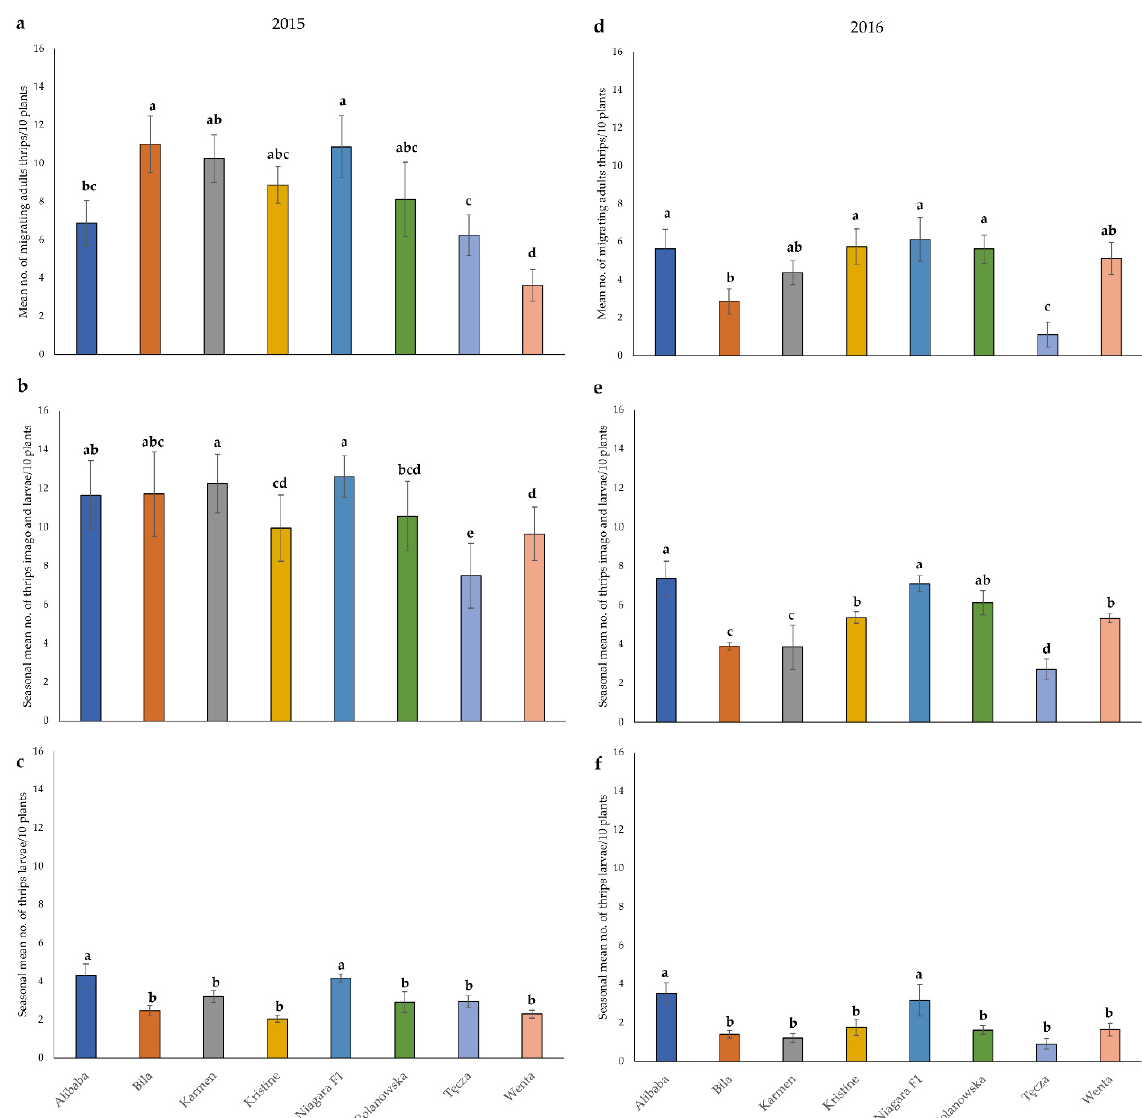
Figure 1. Mean (±SE) Thrips tabaci abundance on onion cultivars: ( a , d ) during onion plants colonization by the adults, ( b , e ) throughout the growing season by adults and larvae, and ( c , f ) by larvae of thrips in 2015 and 2016. Means with the same letters on each bar do not differ significantly (Duncan’s multiple range Test, p < 0.05).